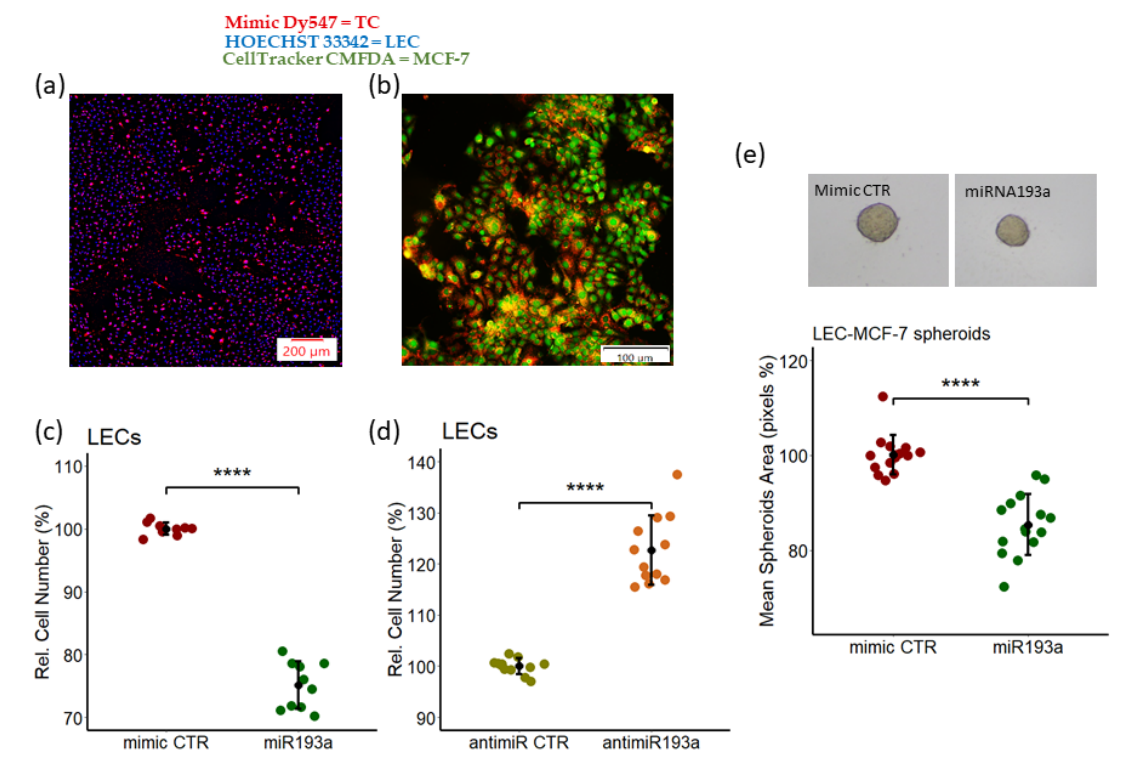
Figure 2. Overexpression of miR193a-3p inhibits LEC proliferation and LEC + MCF-7 spheroid growth. Representative fluorescent photomicrograph showing transfection efficiency of miR193a-3p in LECs ( a ) and MCF-7 cells. ( b ) Red: mimic Dy547; blue: HOECHST 33342; green: CellTracker Green CMFDA; TC: transfected cells. Scale bar: 200 μ m ( a ) and 100 μ m ( b ). LECs transfected with control (CTR) mimic/miR193a or anti-miRNA CTR/antimiR193a and LEC-MCF7 spheroids were developed using miR193a-3p, and transfected LECs and MCF-7 cells were grown in a 2.5% steroid-free serum-containing medium. After 3 days, growth was assessed by cell counting ( c ) and ( d ) and measuring spheroid area ( e ). Pictures of spheroids were taken on day 4 and analyzed using ImageJ software to calculate spheroid area. Experiments were conducted at least three times in triplicates or quadruplicates. p < 0.0001 **** compared to the respective control.